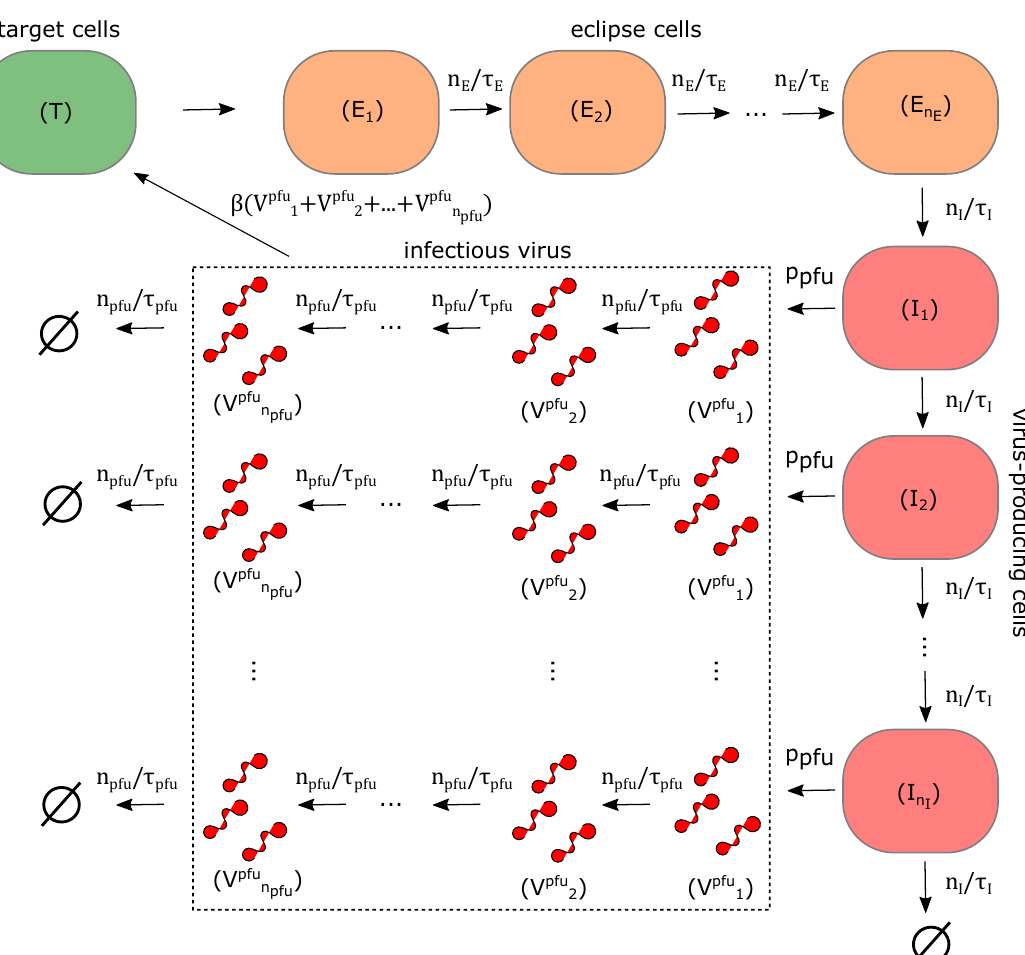
Figure 4. Graphical representation of the model (3) described in Materials and Methods. Susceptible target cells (green) get infected by infectious virus at any stage of its infectious life (dotted rectangle). After entering an eclipse phase, eclipse cells (orange) remain in the eclipse phase for an average time ( τ E ), after which they transition into the virus-producing phase and begin releasing virus. Virus-producing cells (red) remain in virus-producing state for an average time ( τ I ) and produce infectious virus at the rate ( p pfu ) and total encapsulated genomes at the rate (( p rna ) the latter is not displayed). Infectious virus remains infectious for an average time ( τ pfu ). Encapsulated viral genomes remain stable for an average time (( τ rna ), not